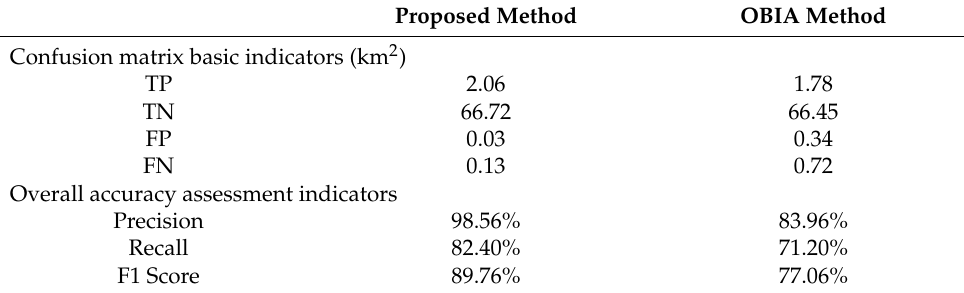
Table 1. Results of the two dam-controlled area extraction